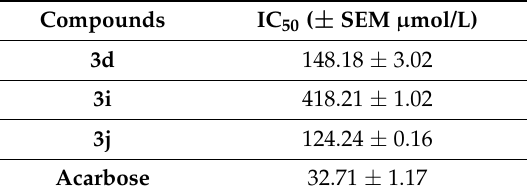
Table 3. Results of α -glucosidase inhibitory